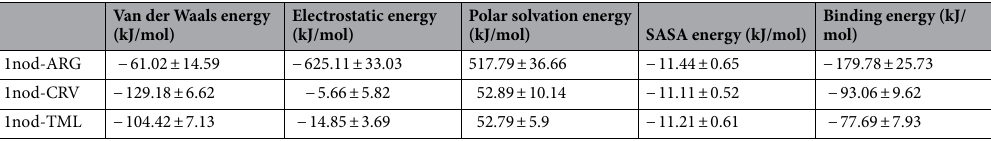
Table 5. Free energy binding of arginine, thymol, and carvacrol to the iNOS enzyme.